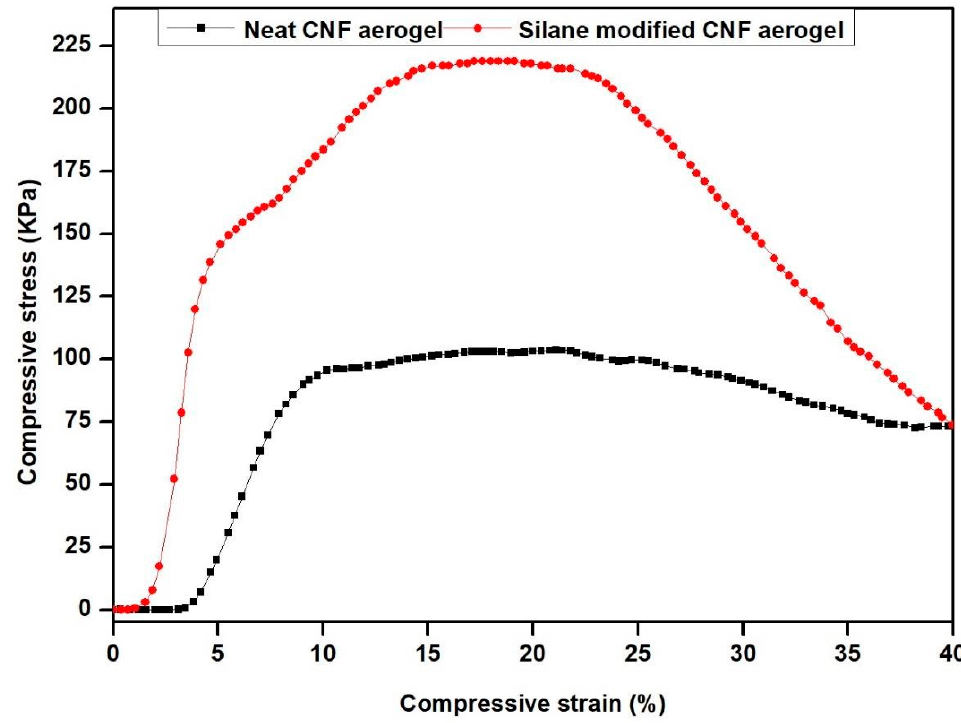
Figure 10. Compressive stress vs. strain curves of silane-modified CNF aerogel and neat CNF aerogel.